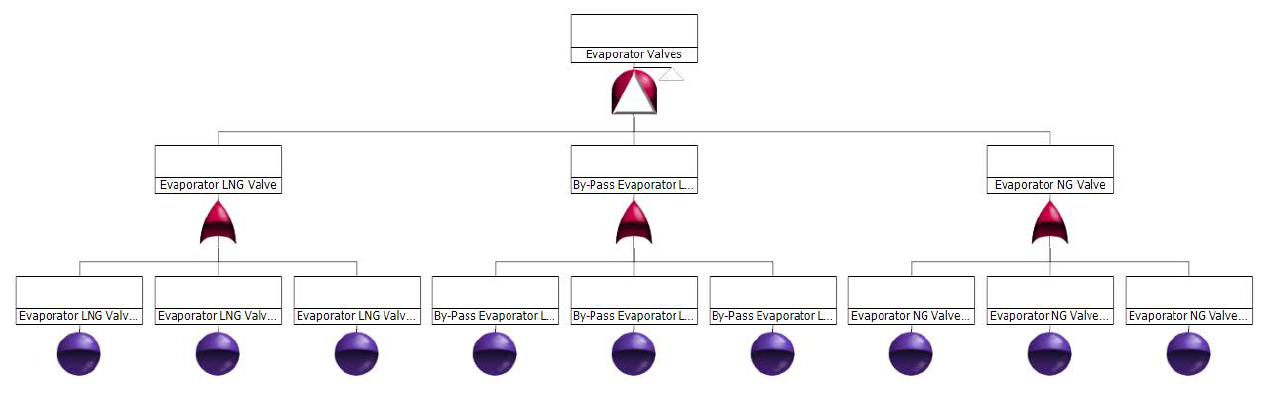
Figure A1. Fault tree for the evaporator valve subsystem developed in PTC Windchill.